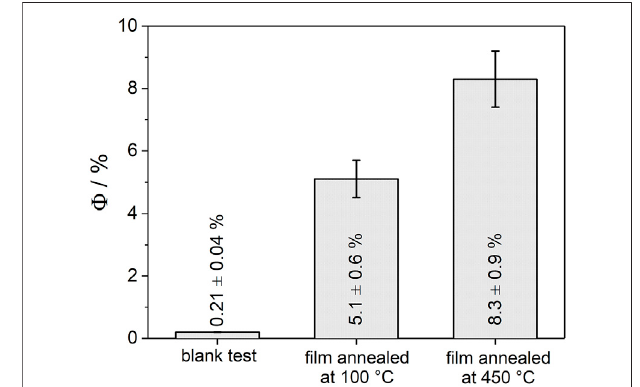
FIGURE 3 | Apparent quantum yield ( Φ ) for H 2 O 2 decomposition on immobilized anatase TiO 2 nanoparticle layers (TiO 2 mass: m (cid:1) 1.5 mg, geometrical area of the fi lm: 1.8 cm 2 , glass substrate) upon UV-exposure ( P (cid:1) 10 mW cm − 2 , λ (cid:1) 360 nm). Films were annealed at 100 or 450 ° C, respectively. The reaction batch was cooled by an ice bath. Two independent experiments using freshly prepared fi lms were performed for each annealing temperature. Blank tests using uncovered glass substrates (i.e., in the absence of the TiO 2 layer) were conducted under otherwise